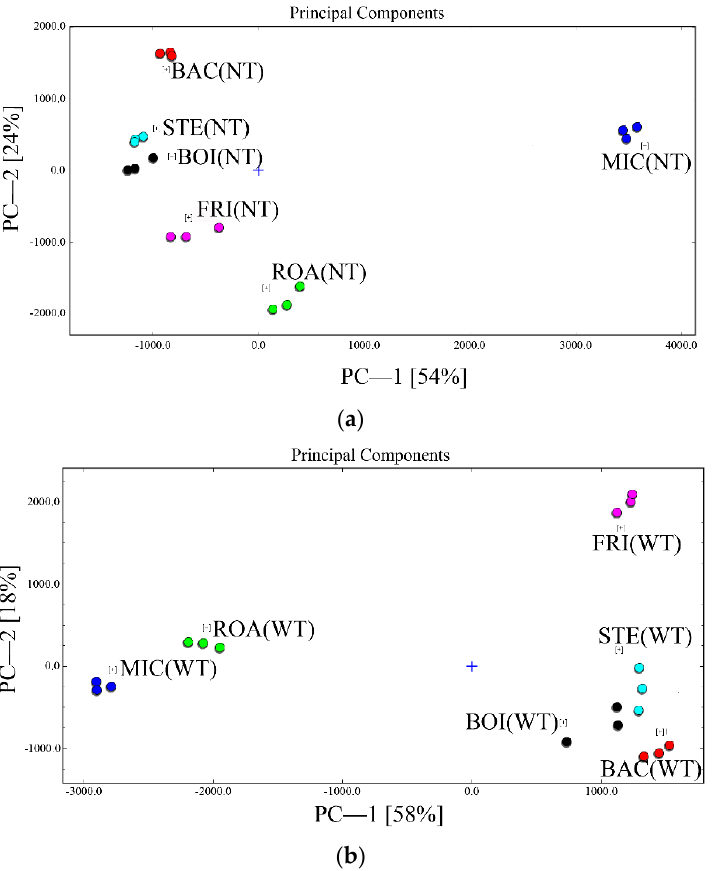
Figure 7. The principal component analysis of volatile flavor substances with surimi products subjected to different thermal treatment methods. ( a ): NT; ( b ): WT; BOI: boiled D. maruadsi surimi products; STE: steamed D. maruadsi surimi products; BAC: back-pressure sterilized D. maruadsi surimi products; ROA: roasted D. maruadsi surimi products; MIC: microwaved D. maruadsi surimi products; FRI: fried D. maruadsi surimi products; NT: group of without TGase; WT: group of with TGase.